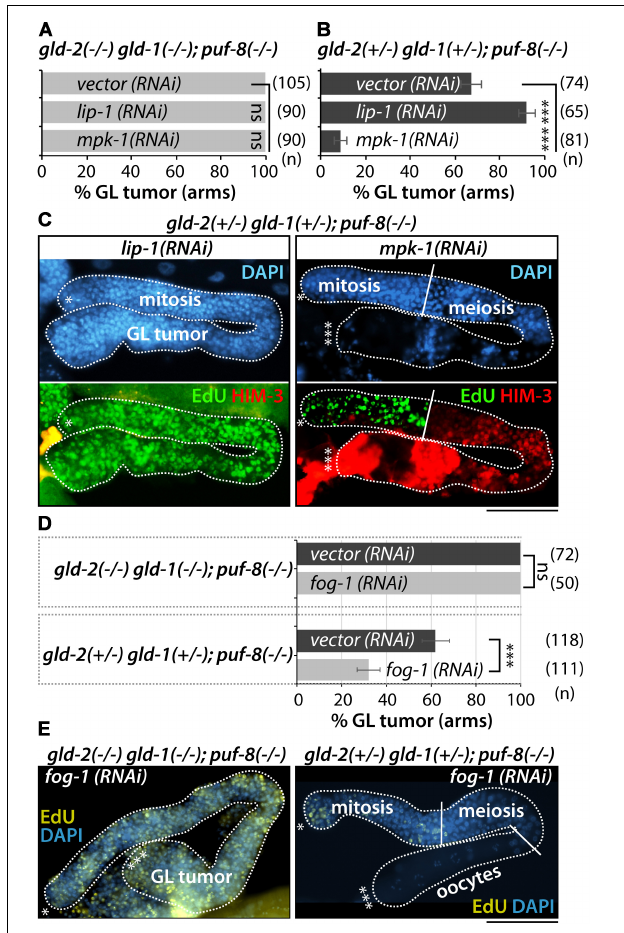
FIGURE 6 | MPK-1 and sperm fate are required for gld-2( + / − ) gld-1( + / − ); puf-8(–/–) germline tumors. (A,B) The percentage of germline tumors at 23 ◦ C. The germline phenotypes were analyzed at 4 days past L1 stage. (C) Staining of dissected adult hermaphrodite germlines with EdU-labeling kit (a marker for mitotic cells), anti-HIM-3 (a marker for meiotic cells), and DAPI (a marker for DNA). (D) The percentage of germline tumors at 25 ◦ C. (E) Staining of dissected adult hermaphrodite germlines with EdU-labeling kit and DAPI. ∗ Distal end of gonads; ∗∗∗ proximal end of gonads; white broken lines, the boundary of gonad; white lines, the boundary of different germ cell types: mitotic region and meiotic region, meiotic region and oocytes. Scale bars, 50 µ